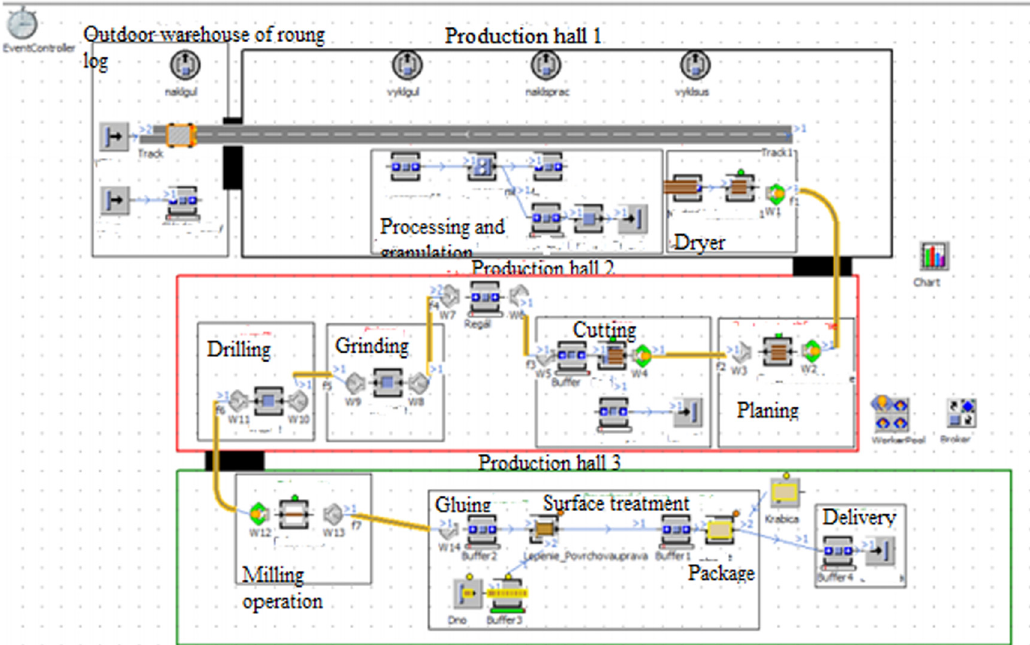
Figure 9: Application of the change in the simulation model. Source: